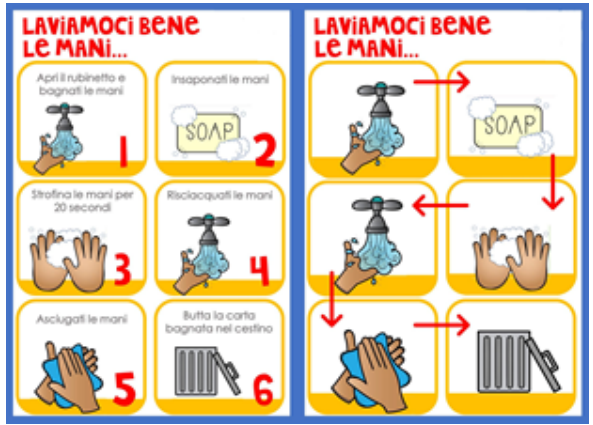
Figure 11. Vertical signs explaining students the most appropriate procedure to wash their hands